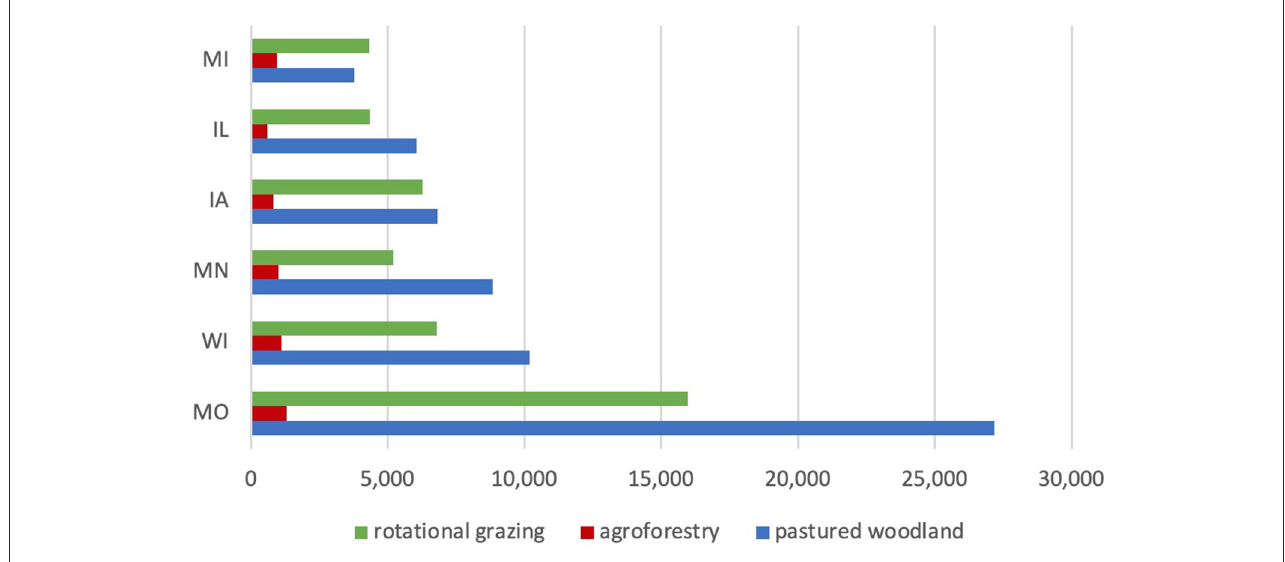
FIGURE1 Number of farms in Wisconsin and nearby states engaged in the following three practices in 2017: rotational grazing, agroforestry (including but not limited to silvopasture), and pastured woodland (which may also include some silvopasture) (USDA-NASS,